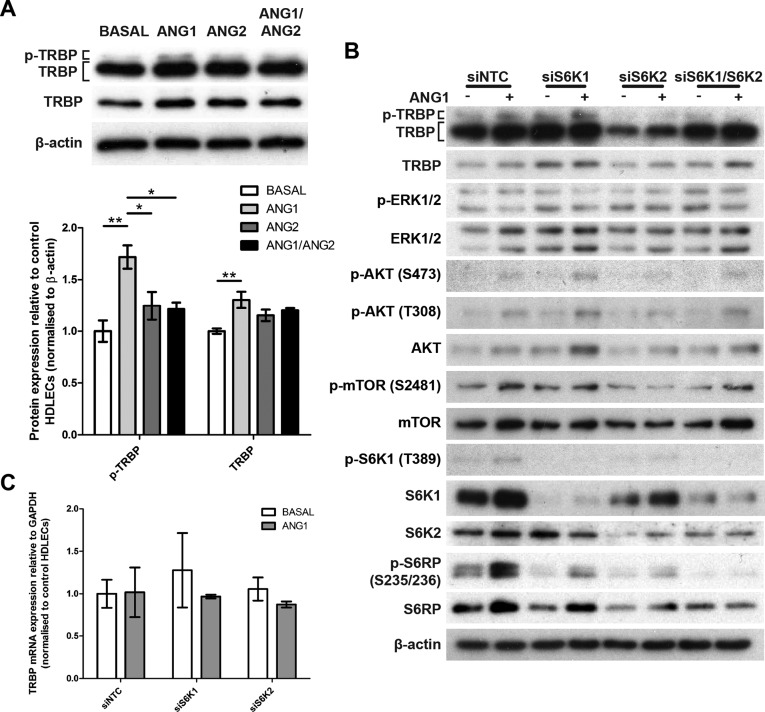
S6K2 is required for ANG1-mediated TRBP activation in HDLECs. (A) TRBP and p-TRBP levels in 24 h ANG stimulated HDLECs. Bar graph shows relative TRBP and p-TRBP levels in 24 h ANG stimulated HDLECs by densitometry. Values are normalized to cells grown in basal media (no growth factors) and are illustrated as mean ± SD (n = 3). P values are shown (*P < 0.05; **P < 0.01). (B) Levels of indicated total and phosphorylated proteins in control (–) and ANG1-stimulated (+) HDLECs (24 h) transfected with non-targeting control (NTC), S6K1, S6K2 and dual S6K1/S6K2 siRNAs. (C) TRBP mRNA levels in HDLECs transfected with non-targeting control (NTC), S6K1, S6K2, and grown without growth factors (Basal) or with ANG1 for 24 h.